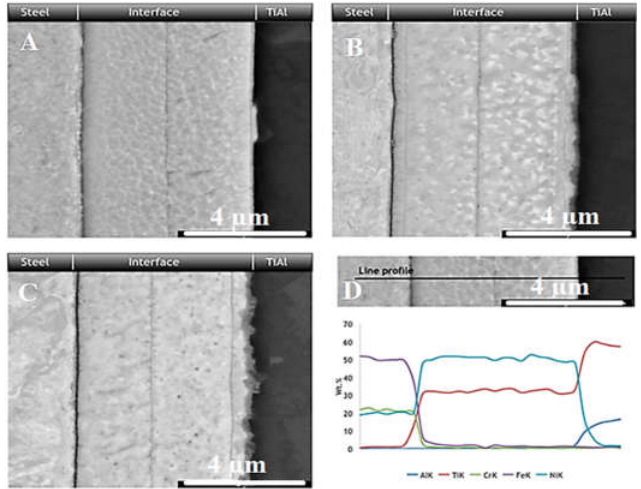
Figure 6. Scanning electron microscope (SEM) micrographs of the TiAl / steel joints produced at; ( A ) 700 ◦ C under a pressure of 50 MPa using Ni / Ti multilayers with 30 nm of bilayer thickness; ( B ) 800 ◦ C under a pressure of 10 MPa using Ni / Ti multilayers with 30 nm of bilayer thickness; ( C ) 800 ◦ C under a pressure of 10 MPa using Ni / Ti multilayers with 60 nm of bilayer thickness and ( D ) Energy dispersive spectroscopy (EDS) profile across the interface presented in ( A )